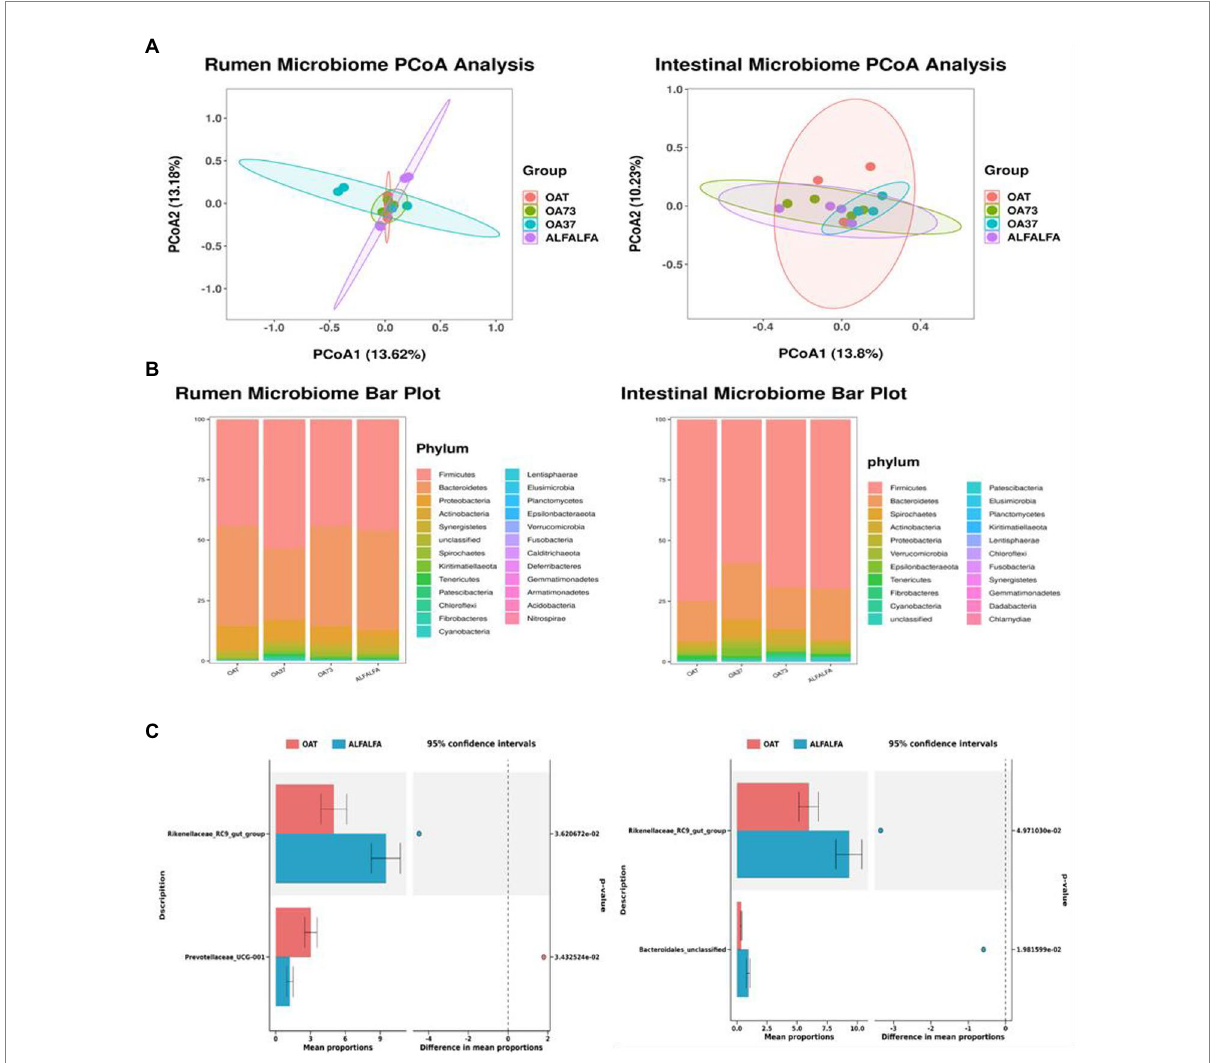
FIGURE 1 Classification of microbiome composition in posterior gut and rumen. (A) Principal component analysis. (B) Differences in microbiome phylum levels among groups. (C) Differences in microbiome genus levels between whole oat and whole alfalfa